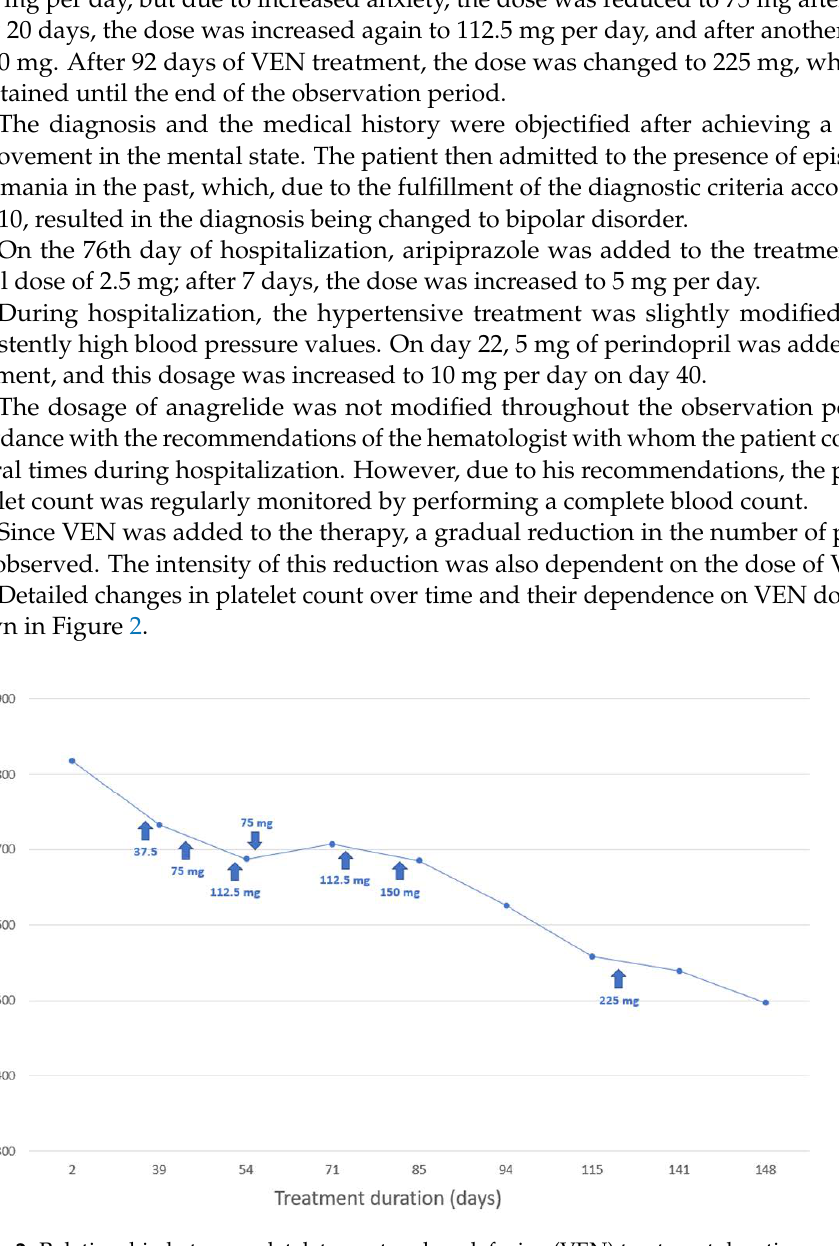
Figure 2. Relationship between platelet count and venlafaxine (VEN) treatment duration and dosage.